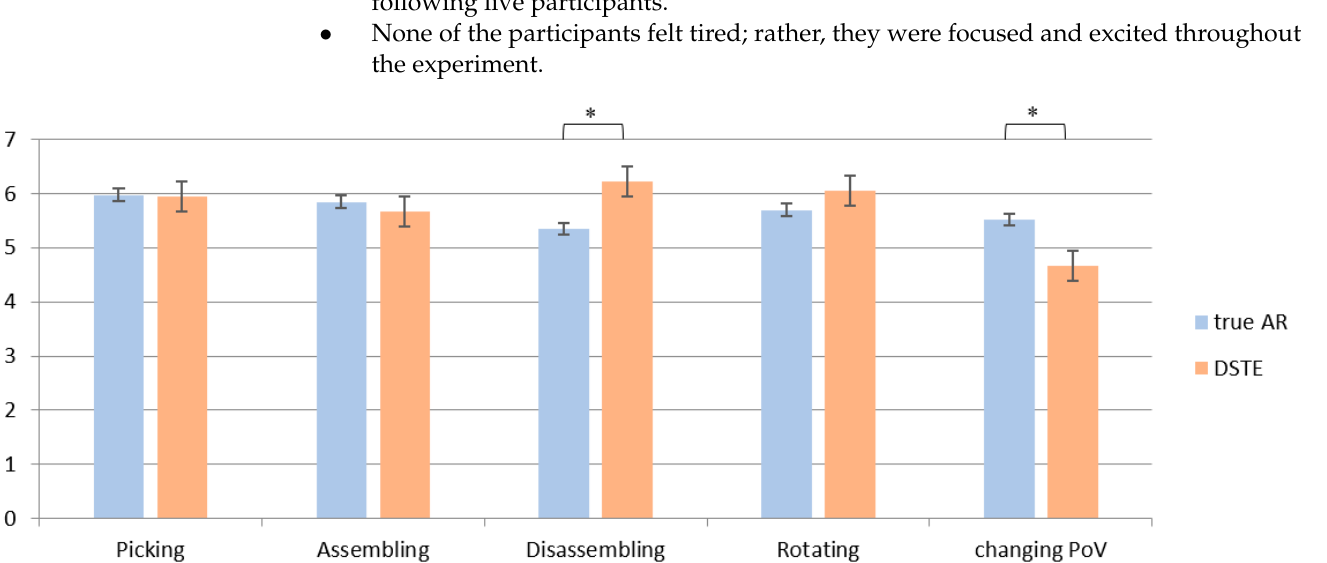
Figure 8. Mean values of user satisfaction reported by participants for interaction with LEGO bricks in the DSTE and in true AR. The asterisks indicate statistically significant different conditions.